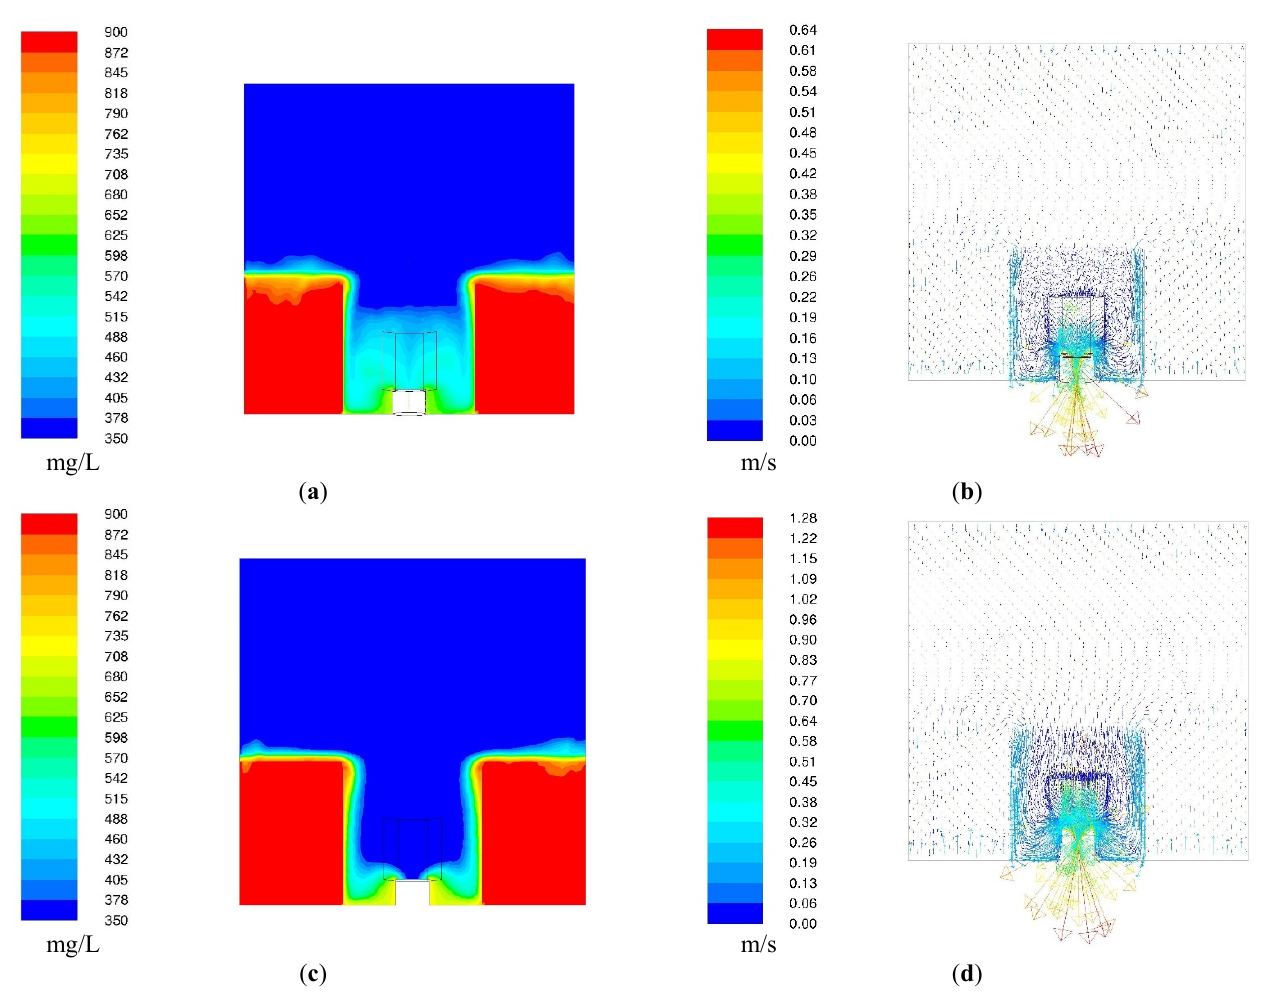
Figure 8. Distribution of mineralization ( a , c ) and vector field of flow velocity ( b , d ) of withdrawn water in the area of the